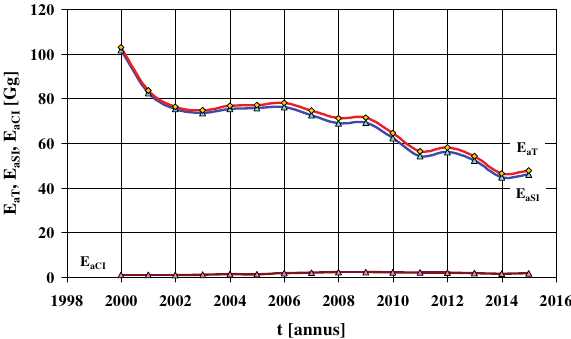
Fig. 7. National annual emission of non-methane organic compounds from passenger cars